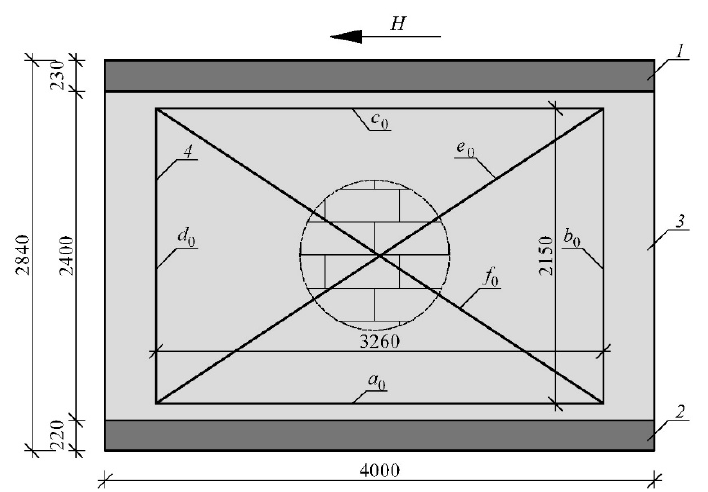
Figure 7. Frame system mounted on each model’s walls to measure shear strain and deformation angle; H —horizontal shear force; 1 —rigid diaphragm; 2 —concrete foundation; 3 —masonry wall made of AAC; 4 —measuring base; a 0 , c 0 —horizontal part of the frame system; b 0 , d 0 —vertical part of the frame system; e 0 , f 0 —diagonal part of the frame system.